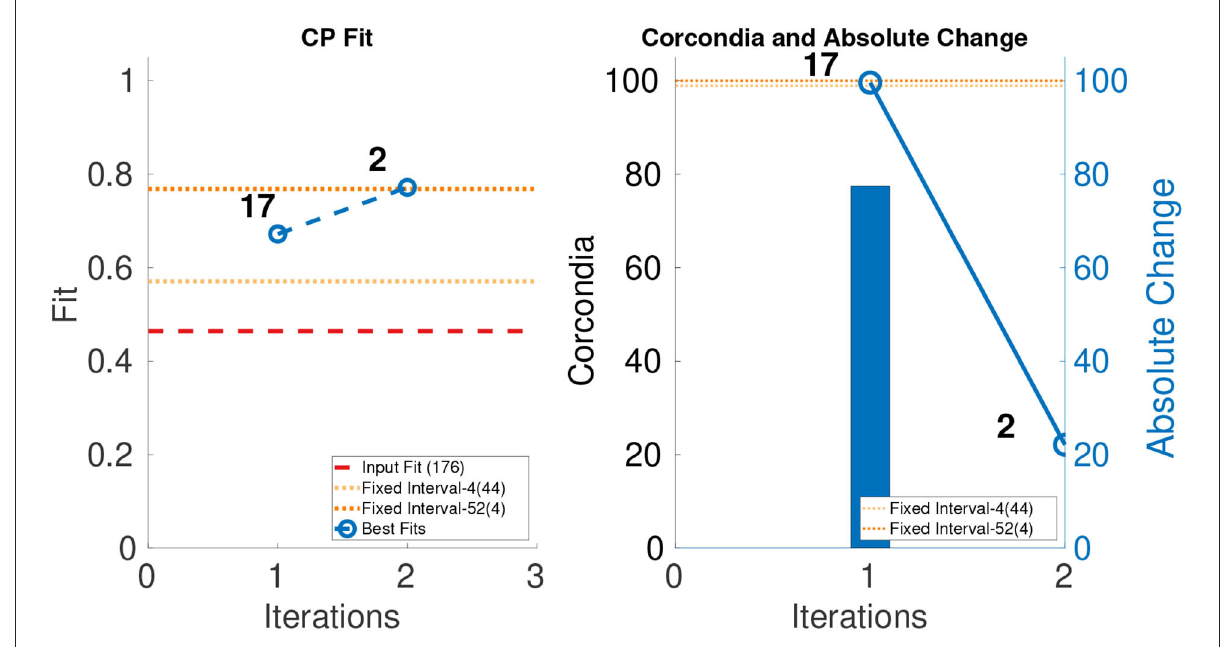
FIGURE5 CP fit and CORCONDIA of best fit tensor and its absolute change at each iteration for Enron Weekly.